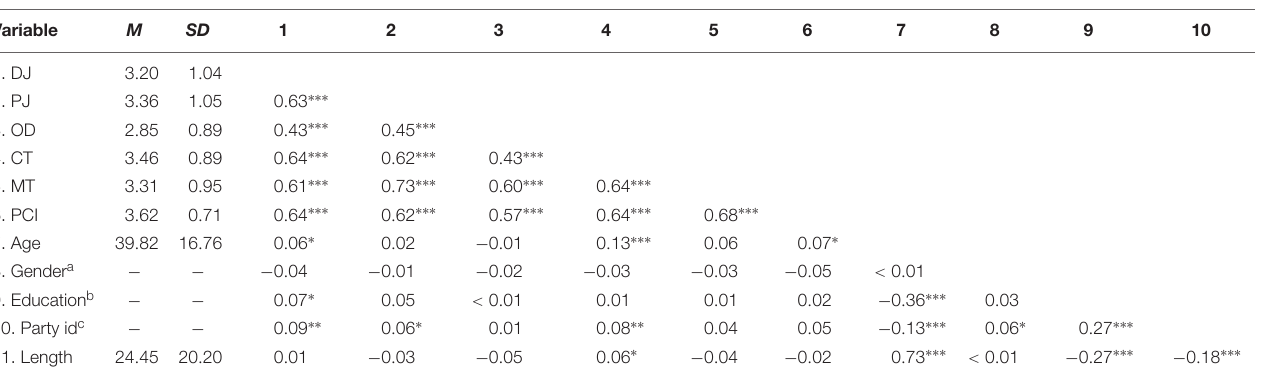
TABLE 5 | Summary of statistics and intercorrelations (Study 2). Variable